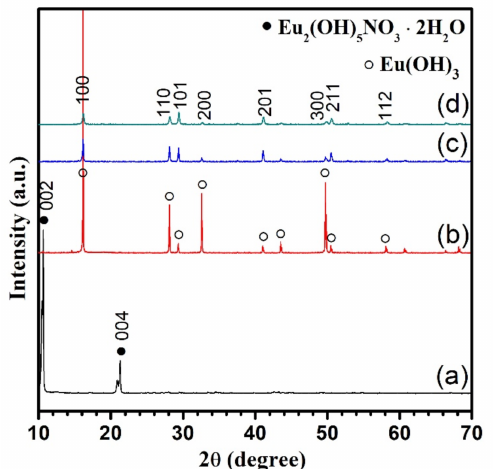
Figure 4. XRD patterns of the products obtained at 220 ◦ C for 24 h as a function of the pH value of the starting solution. The pH value used is 7.63 ( a ), 9.15 ( b ), 10.90 ( c ), 12 ( d ).